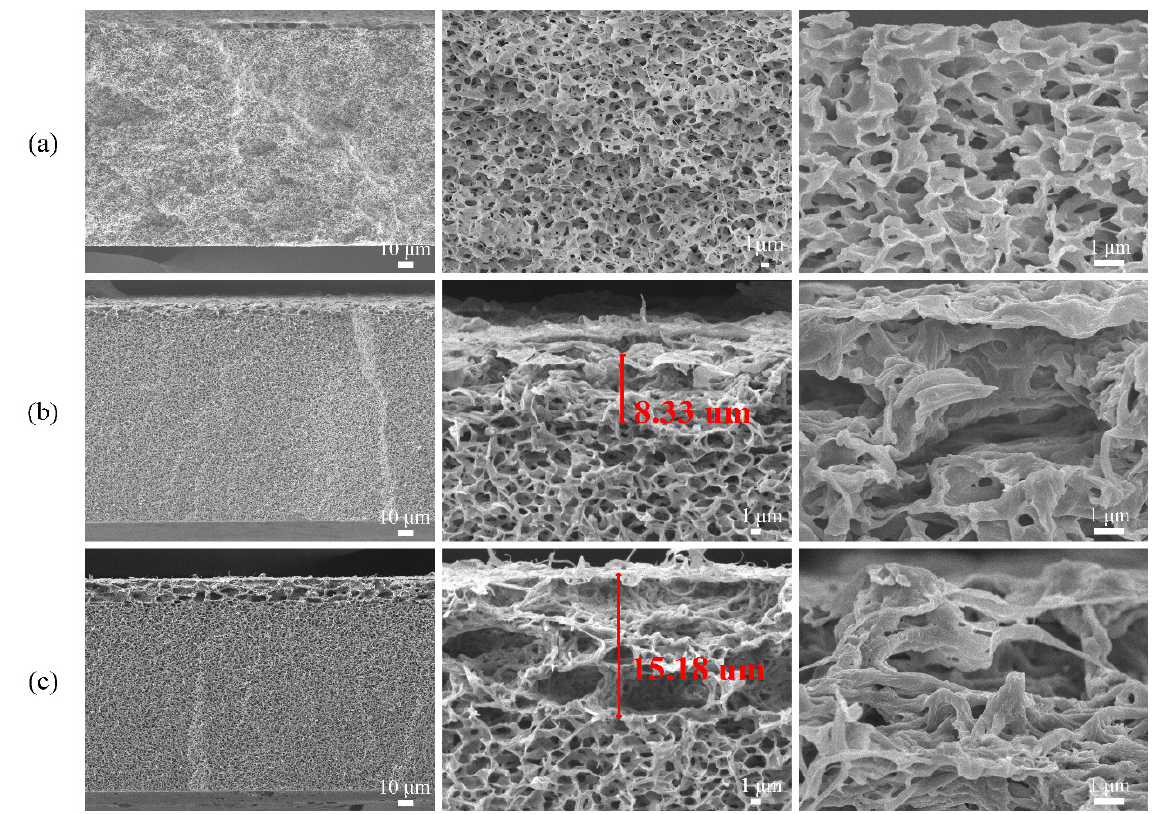
Figure 2. SEM images of the cross section of modified membrane: ( a ) M0, ( b ) M1, ( c ) M3.